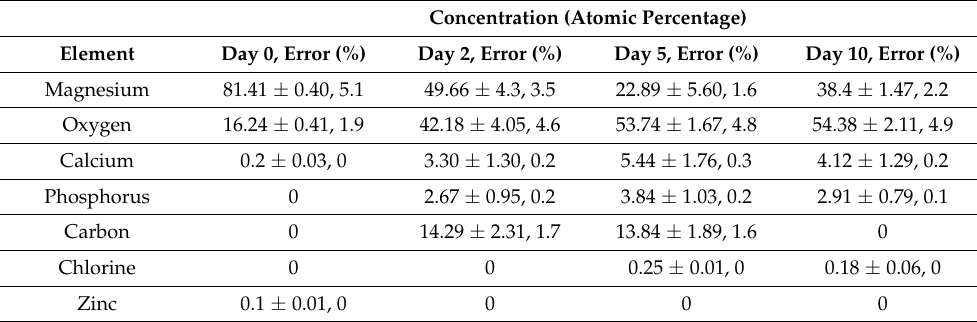
Figure 3. The scanning electron micrograph (SEM) of the surfaces of Mg, pure Mg, and Ti after 0, 3, 5, and 10 days of in vitro corrosion in DMEM solution. Table 1. Quantitative composition and elementary identification information for the Mg alloy in atomic percentage with